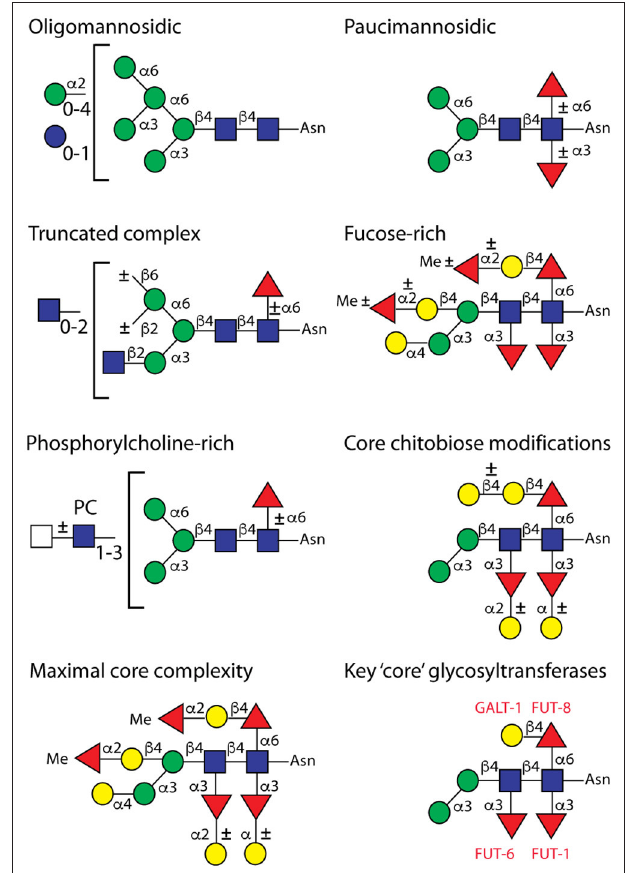
FIGURE 2 | Example C. elegans wild-type N-glycan structures. This summary is an updated version of our 2008 figure (Paschinger et al., 2008), which was originally based on the classification of Haslam and Dell (2003). The classifications are not rigid, as “fucose-rich” and “core chitobiose modified” glycans are also paucimannosidic in the sense that they contain two mannose residues. The maximal core complexity shows a glycan found upon hydrazine release and the definition of the enzymes (red lettering) modifying the core is based on in vitro assays and glycomic analyses of mutants.